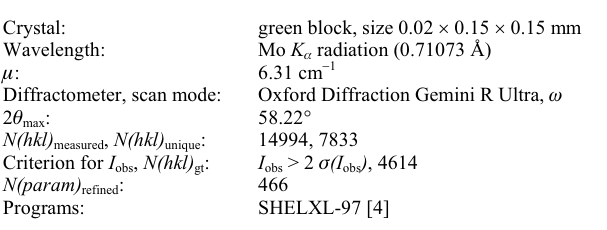
Table 1. Data collection and handling.